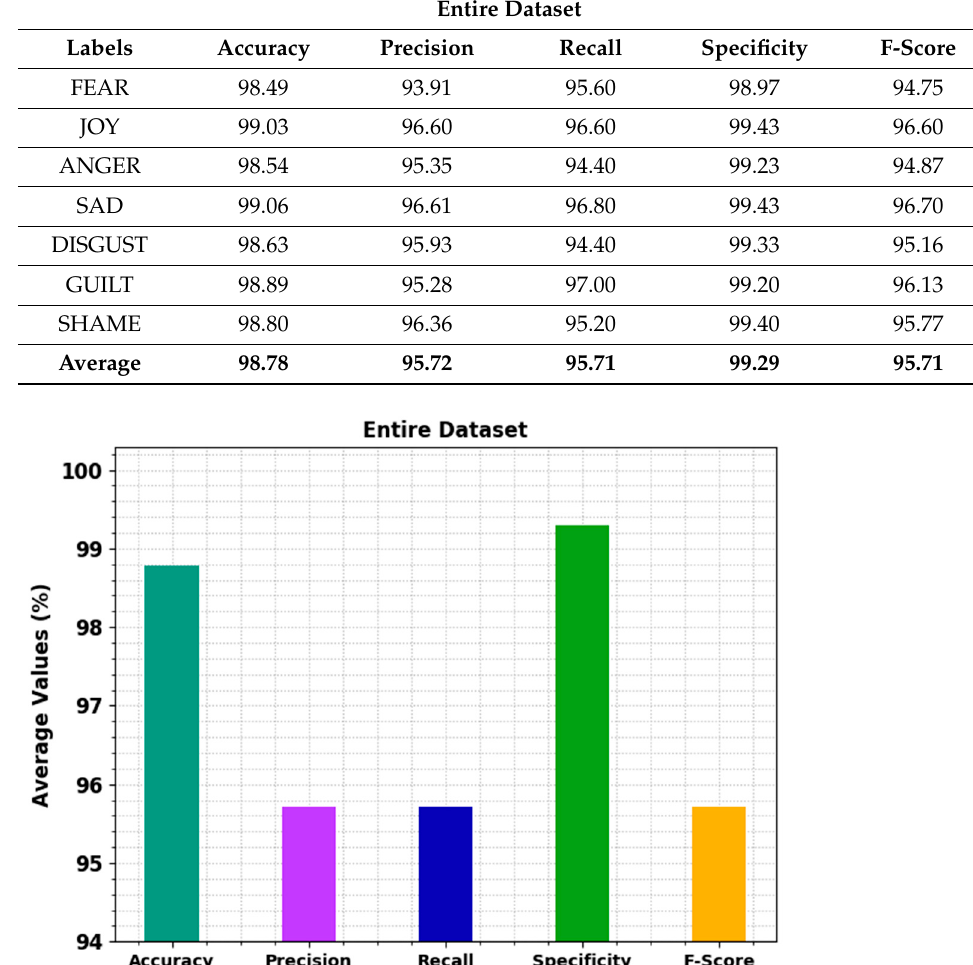
Table 3. Result analysis of CLBEDC-SND approach with distinct class labels under 70% of TR data.